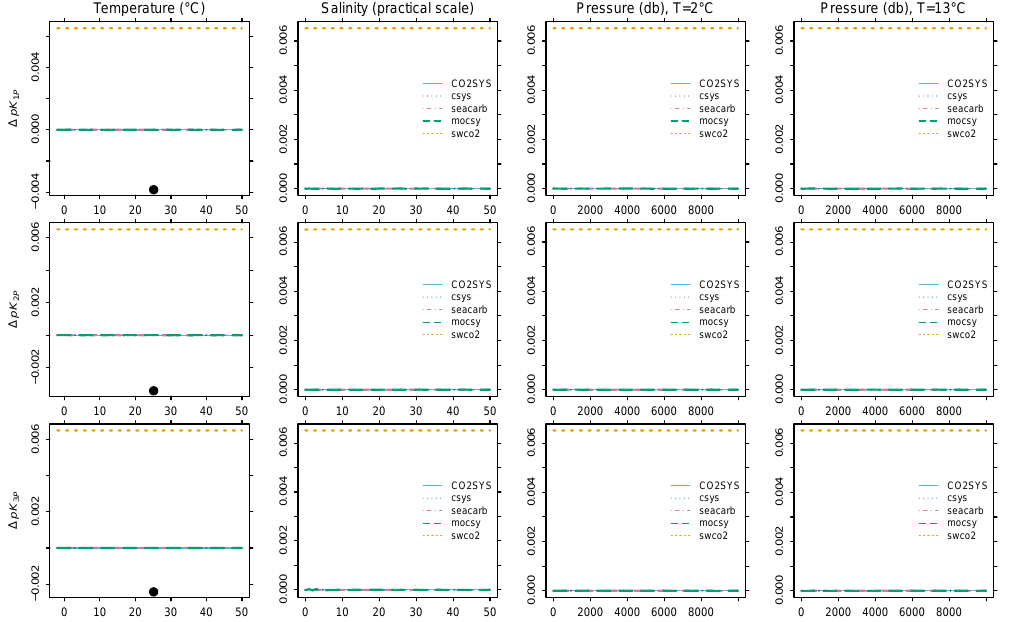
Figure 19. The p K 1P (top), p K 2P (middle), and p K 3P (bottom) computed from each package minus corresponding values from CO2SYS- MATLAB. Formulations are from Millero (1995), as recommended for best practices. Constants are computed across the same ranges of T (column 1), S (column 2), and P when T = 2 ◦ C (column 3) and when T = 13 ◦ C (column 4) as used in previous figures. The filled black circles indicate the check values (Table